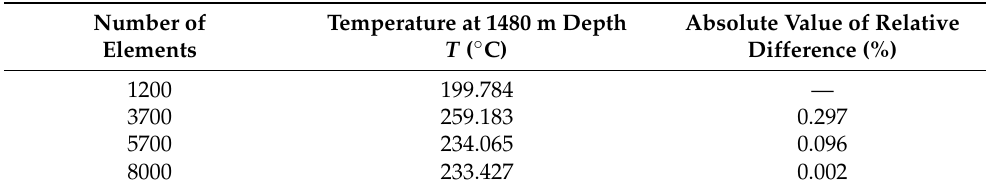
Table A2. Verification of mesh independence for simulation of scenario 1 at the location of